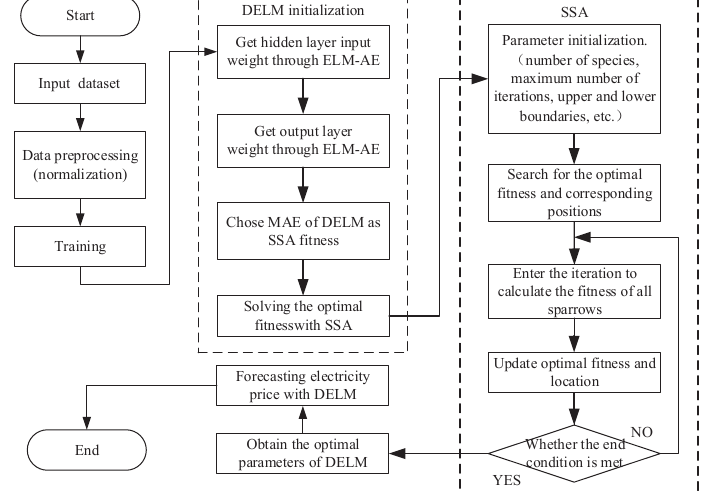
Figure 1. Flow chart of SSA-DELM.